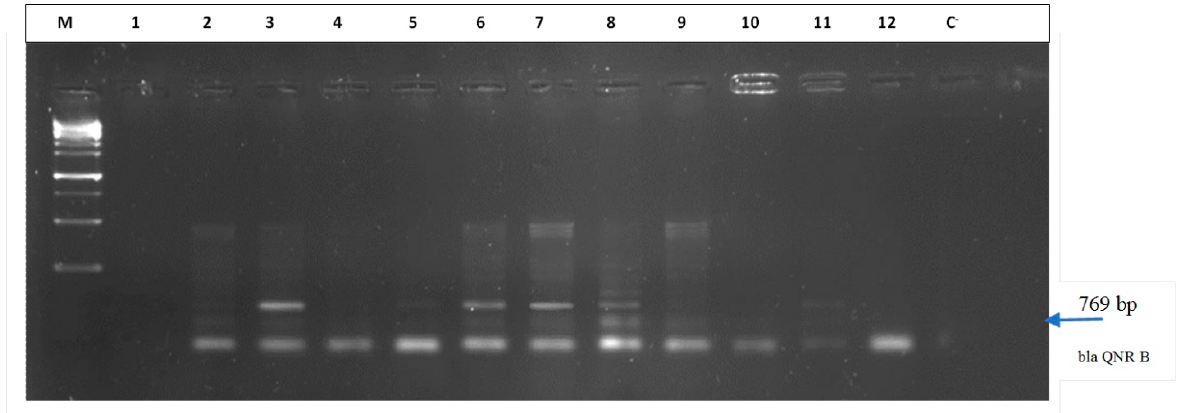
Figure 2. Agarose gel image showing the PCR products of the bla QNR B gene. Lane (M) = molecular weight marker; Lane (3; 6; 7; 8; 11) = positive to bla QNR B gene; Lane (C − ) = negative control.